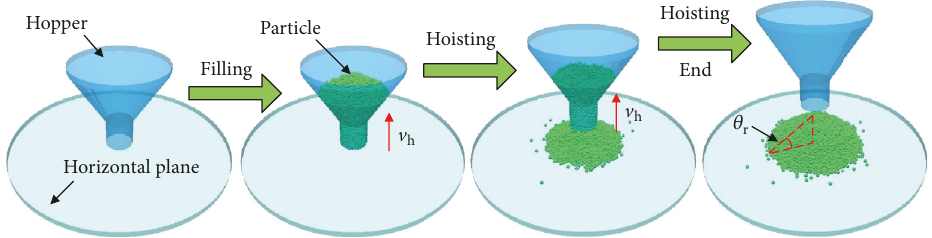
Figure 8: Procedure to measure the